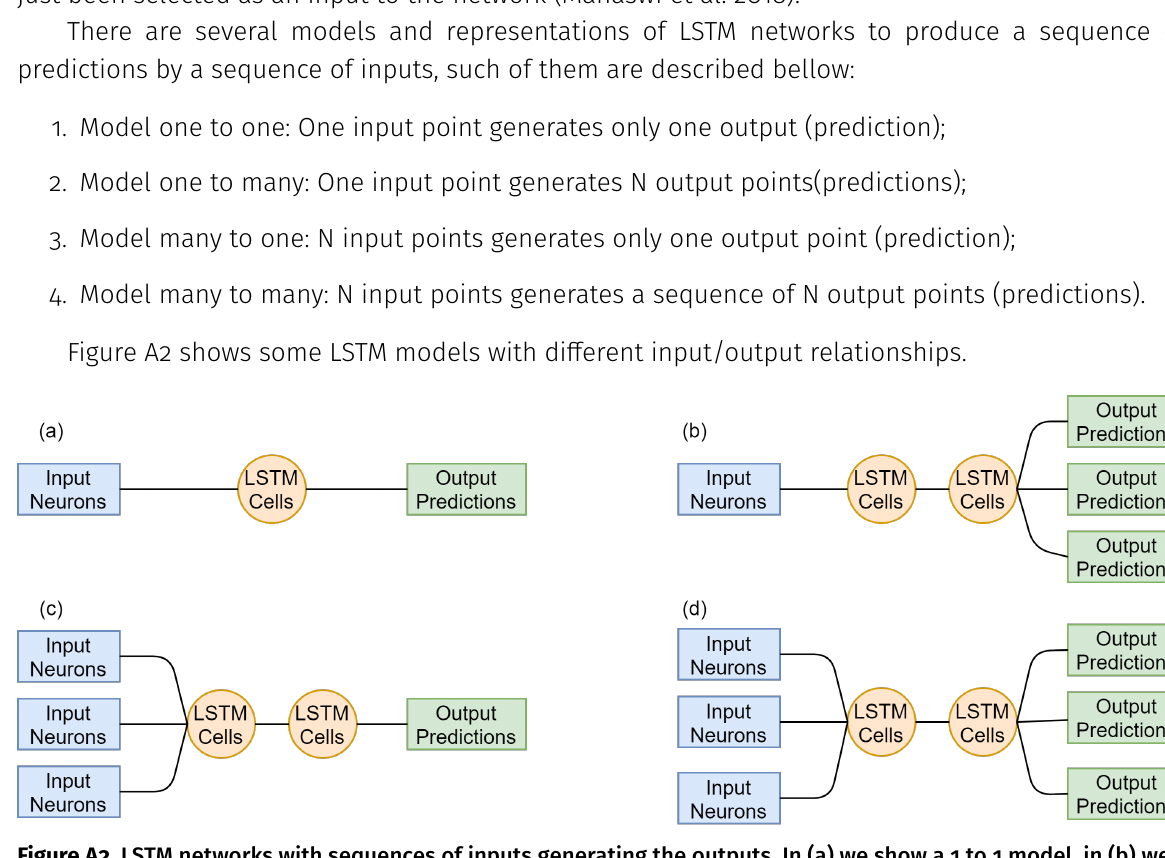
Figure A2. LSTM networks with sequences of inputs generating the outputs. In (a) we show a 1 to 1 model, in (b) we show the 1 to N model, in (c) we show the N to 1 model, and in (d) we show the N to N model. In this work, all the LSTM prediction models work as a N to N